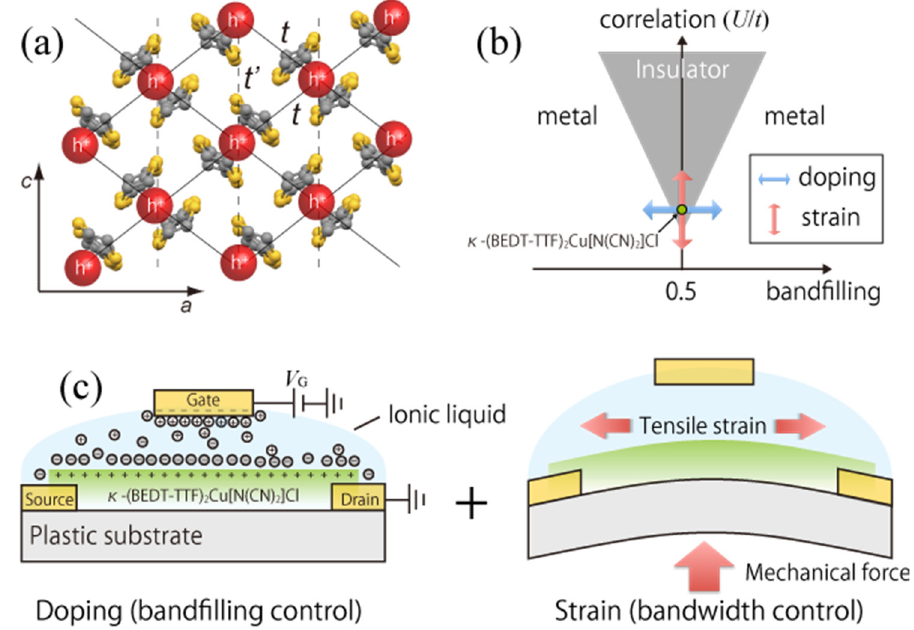
Figure 1. ( a ) Conducting BEDT-TTF layer in κ -(BEDT-TTF) 2 Cu[N(CN) 2 ]Cl. ( b ) Conceptual phase diagram based on the Hubbard model [1]. The vertical axis denotes the strength of the electron correlation. κ -(BEDT-TTF) 2 Cu[N(CN) 2 ]Cl is located near the tip of the insulating region. ( c ) Schematic side view of the device structure. Doping concentration and bending strain are controlled by EDL gating and substrate bending with a piezo nanopositioner, respectively.